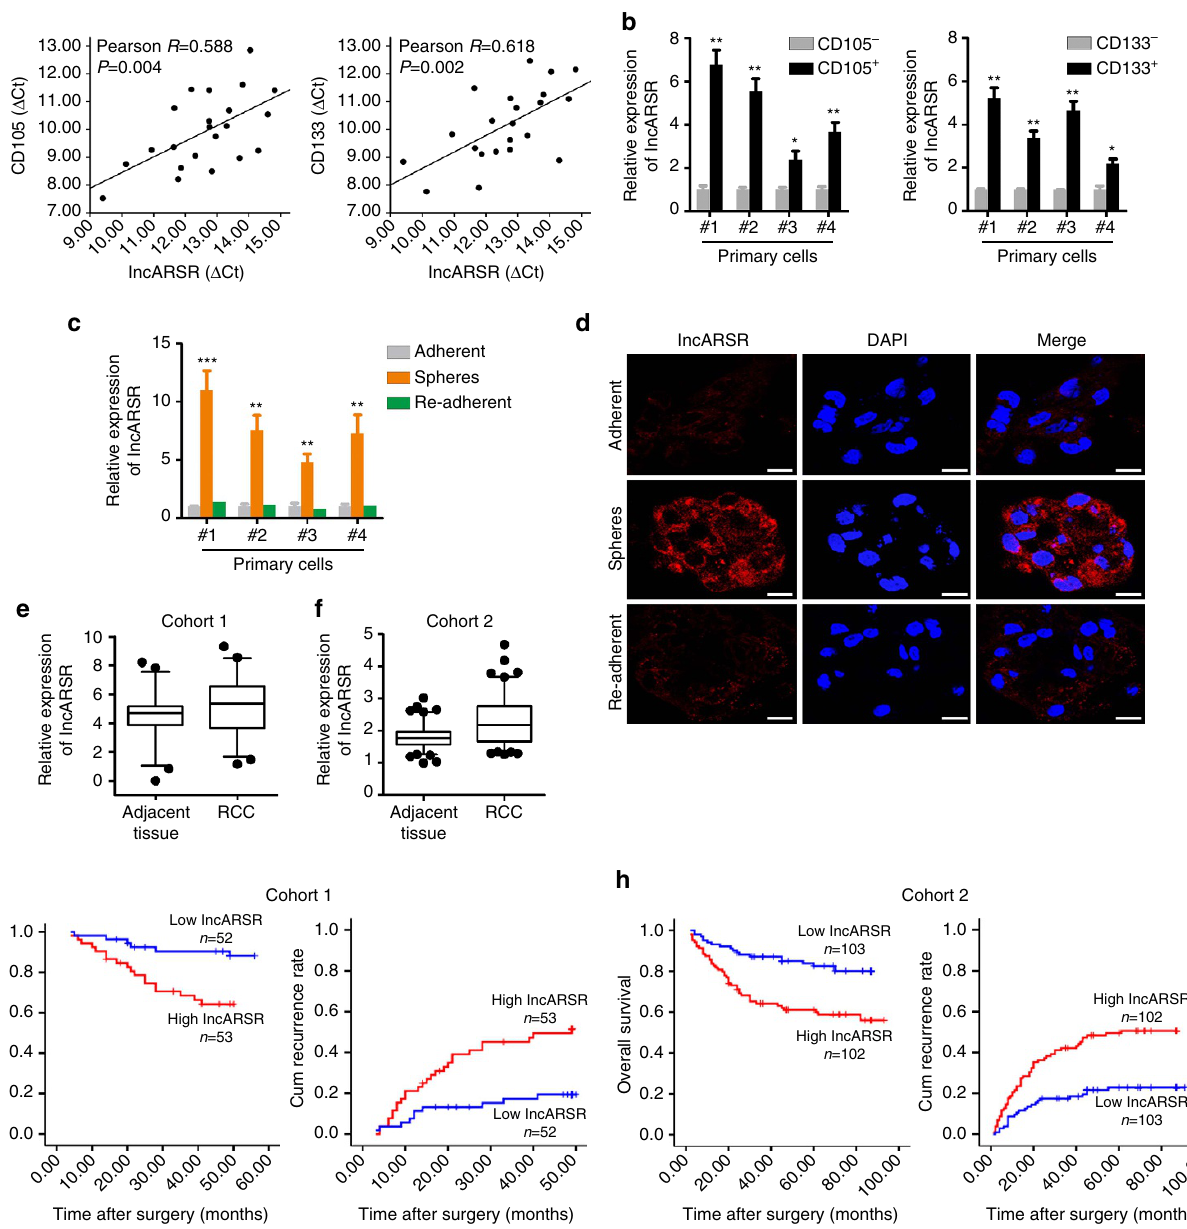
Figure 1 | lncARSR is upregulated in T-ICs and predicts poor prognosis. ( a ) The correlation between the transcription level of lncARSR and CD105 (left) or CD133 (right) in primary ccRCC cells ( n ¼ 22) was determined by qRT–PCR analysis. Data were normalized to b -actin as D Ct and analysed by Spearman’s correlation analysis. ( b ) qRT–PCR analysis of lncARSR in MACS sorted CD105 þ (left) or CD133 þ (right) primary ccRCC cells relative to negative cells. Data are represented as mean ± s.d.; * P o 0.05 and *** P o 0.001; two-tailed Student’s t -test. ( c ) qRT–PCR analysis of lncARSR in primary ccRCC adherent, spheres and re-adherent cells. Data are represented as mean ± s.d.; ** P o 0.01 and *** P o 0.001; two-tailed Student’s t -test. ( d ) FISH analysis of lncARSR in primary ccRCC #4 adherent and sphere cells using biotin-labelled LNA probe. The nuclei were stained with DAPI. Scale bar, 20 m m. ( e ) lncARSR expression in human ccRCC tissues and adjacent tissues determined by qRT–PCR analysis in cohort 1 ( n ¼ 105, P o 0.001, Mann–Whitney U -test). The lncARSR expression was normalized to b -actin ( D Ct) and compared with the maximum D Ct. Data are presented as (cid:2) DD Ct. The horizontal lines in the box plots represent the median, the boxes represent the interquartile range and the whiskers represent the 2.5th and 97.5th percentiles. ( f ) lncARSR expression in human ccRCC tissues and adjacent tissues determined by RNA in situ hybridization (ISH) analysis in cohort 2 ( n ¼ 205, P o 0.001, Mann–Whitney U -test). The lncARSR expression was normalized to the minimum signal of lncARSR positive staining. The horizontal lines in the box plots represent the median, the boxes represent the interquartile range, and the whiskers represent the 2.5th and 97.5th percentiles. ( g ) Kaplan–Meier analysis of overall survival (left, P o 0.001, log-rank test) or recurrence rate (right, P o 0.001, log-rank test) of ccRCC patients in low and high lncARSR groups in cohort 1. ( h ) Kaplan–Meier analysis of overall survival (left, P o 0.001, log-rank test) or recurrence rate (right, P o 0.001, log-rank test) of ccRCC patients in low and high lncARSR groups in cohort 2.